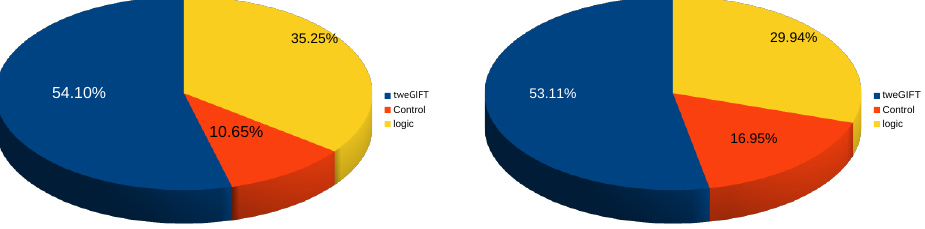
Figure 8: Distribution of Components by #LUTs for LOCUS (left) and LOTUS (right) design accept 64 bit or 8 byte data blocks and the cpb is (29 a + 57 m ) / 8 m . Assuming a = m , we have a constant value of cpb that equals to 60 / 8 = 10 .